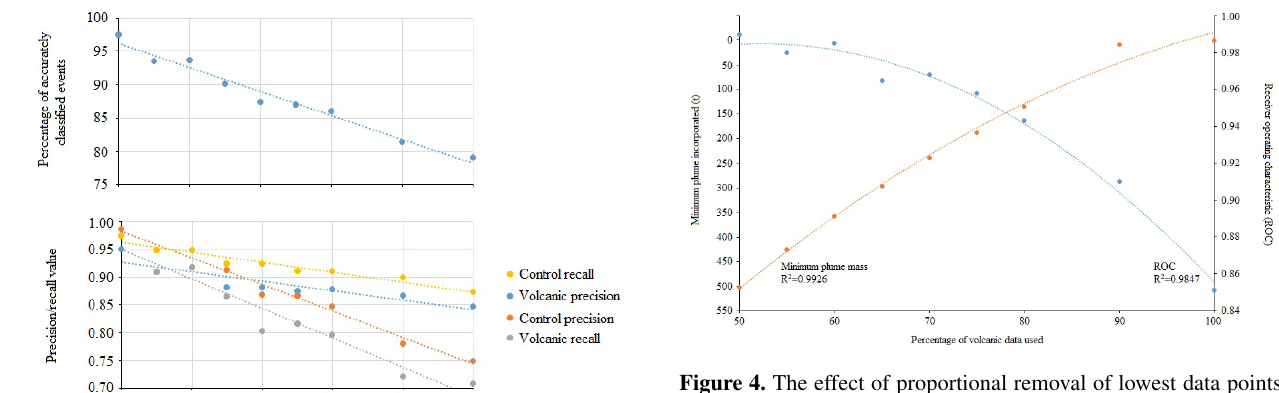
Figure 4. The effect of proportional removal of lowest data points on minimum incorporated SO 2 mass from the volcanic dataset and the ROC (receiver operator characteristic) statistic of each model where ROC = 1 implies all events correctly